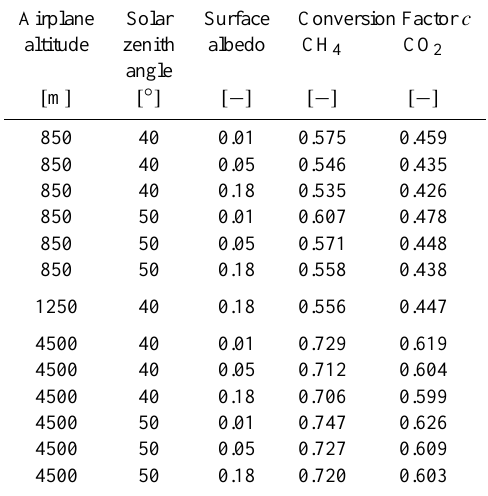
Table 2. MAMAP total column conversion factors c for retrieval output profile scaling factors (PSF), assuming all deviations from mean column occurred below the aircraft. All conversion factors were computed based on SCIATRAN RTM